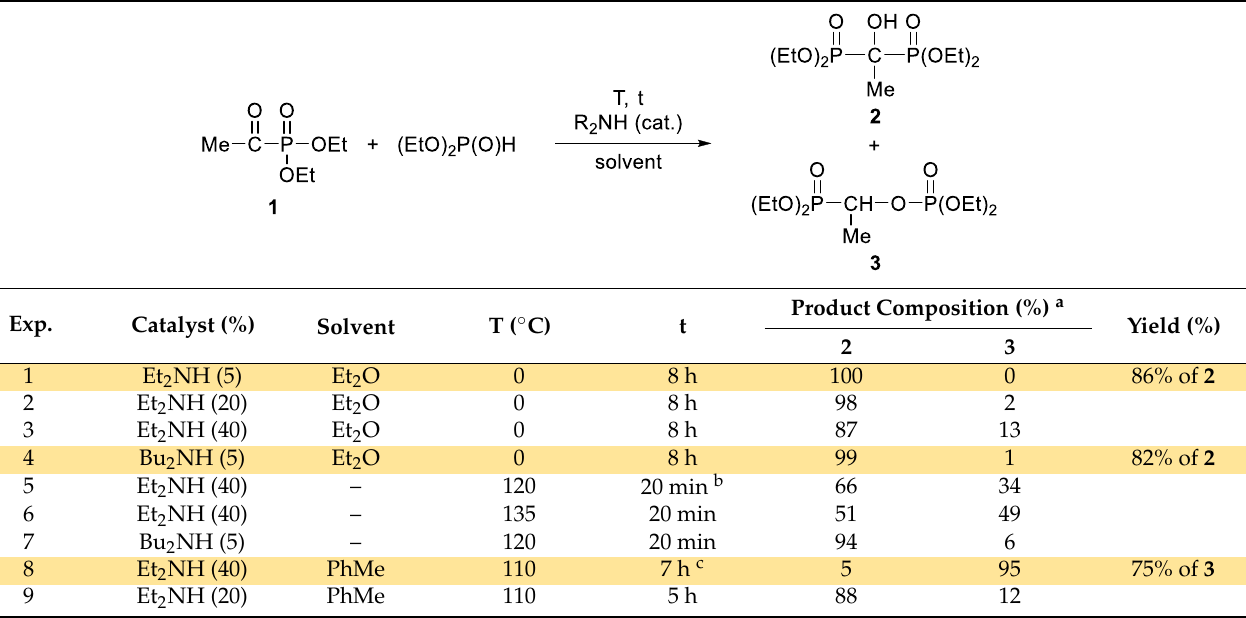
Table 1. The reaction of diethyl α -oxoethylphosphonate ( 1 ) with diethyl phosphite under different conditions.